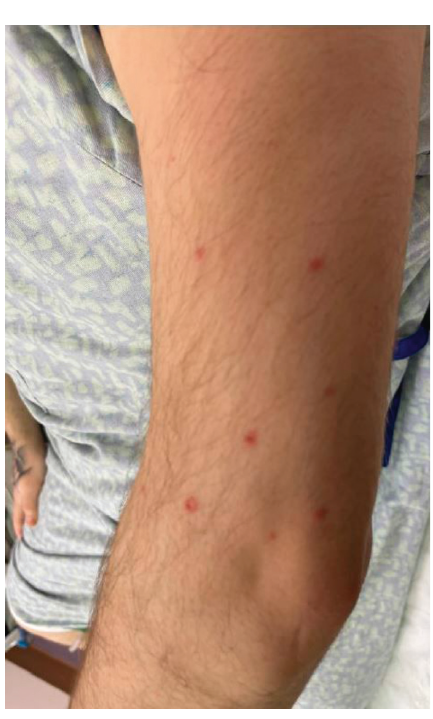
Figure 6: Maculopapular lesions on the left